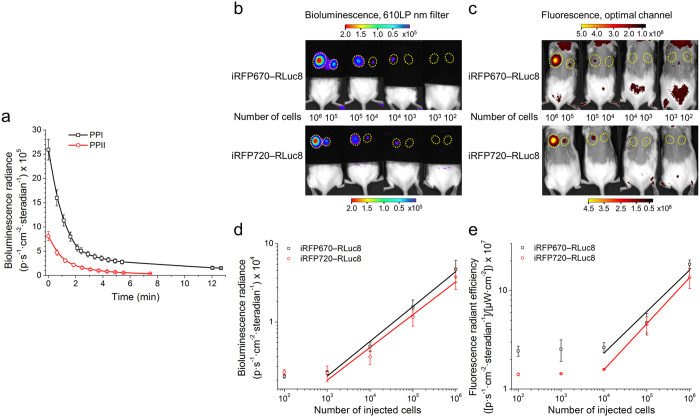
In vivo kinetics and comparative multimodal BLI and FLI of subcutaneously implanted cells.(a) Bioluminescence reaction kinetics of PPI and PPII substrates catalyzed by 106 subcutaneously implanted MTLn3 cells stably expressing iRFP720—RLuc8. (b) BLI and (c) FLI of MTLn3 cells stably expressing iRFP670—RLuc8 or iRFP720—RLuc8 subcutaneously implanted in CFW mice (dorsal view). The color bars indicate the total bioluminescence radiance (photons s−1 cm−2 steradian−1) or the total fluorescence radiant efficiency (photons s−1 cm−2 steradian−1 per μW cm−2). The yellow circles represent regions of interest (ROI) used for data quantification. (d) Values of bioluminescence signal for the images in (B). (e) Values of fluorescence signal for the images in (c). The black and red lines represent linear approximation of dependence of logarithm of the signal strength on logarithm of the number of cells. Error bars, s.d. (n = 6).